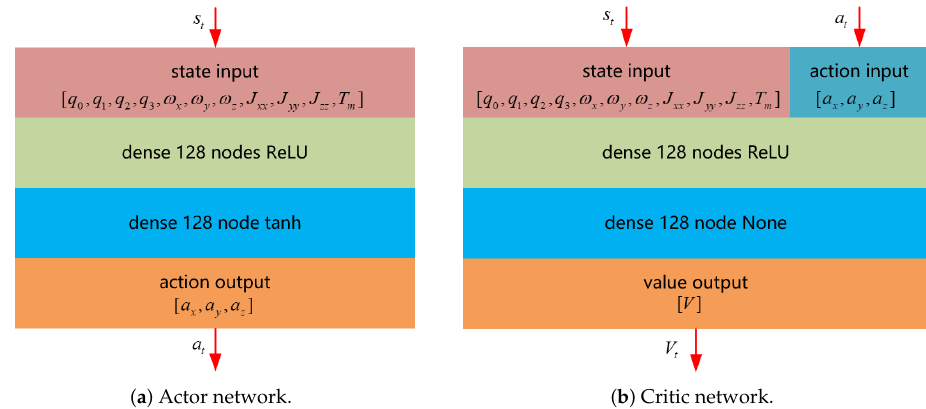
Figure 5. The RL networks